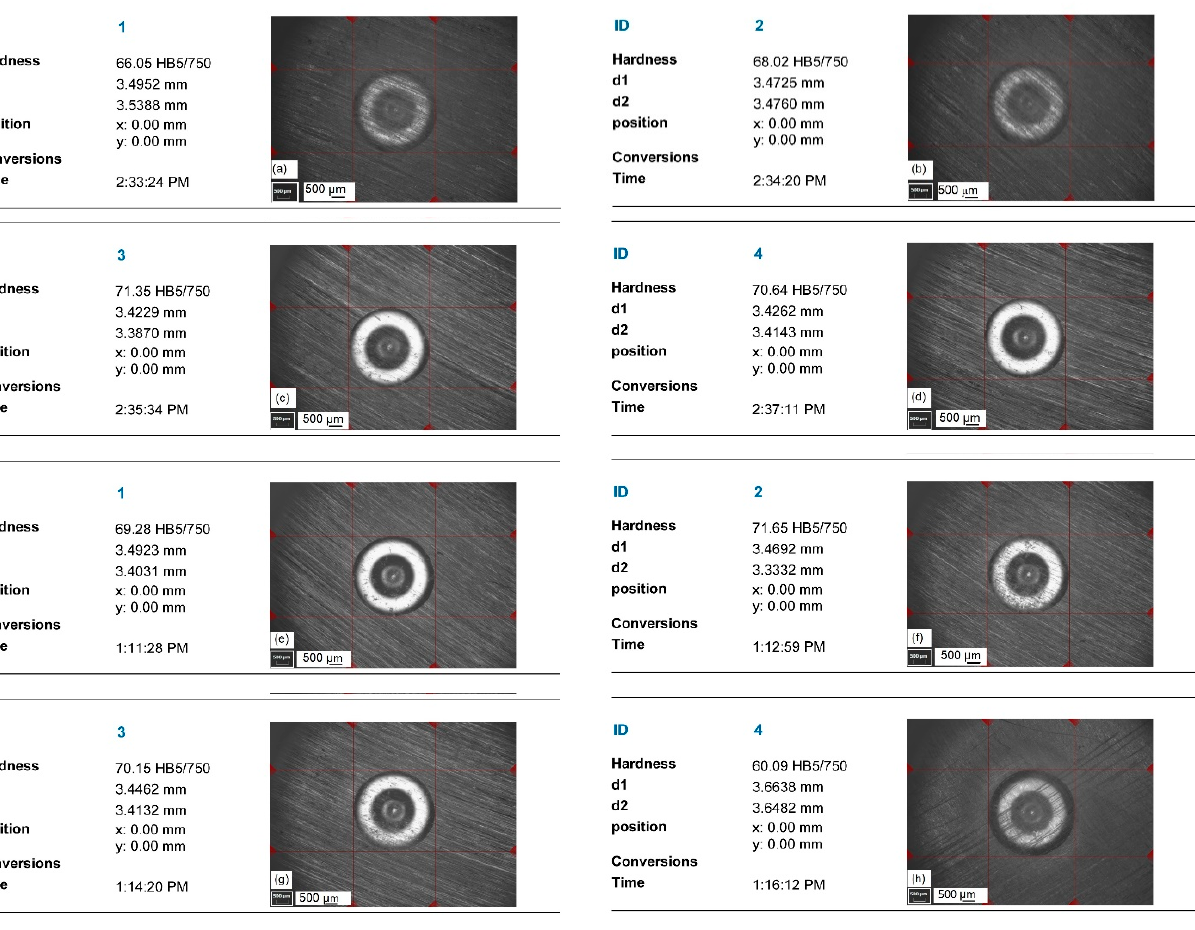
Figure 4. ( a – h ) Hardness testing data and images of the indentation of the ball on the copper.